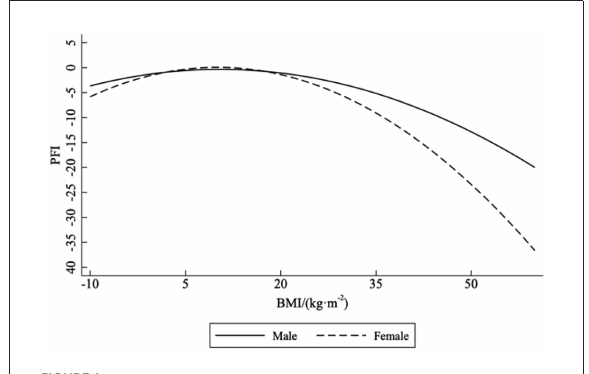
FIGURE1 The relationship between PFI and